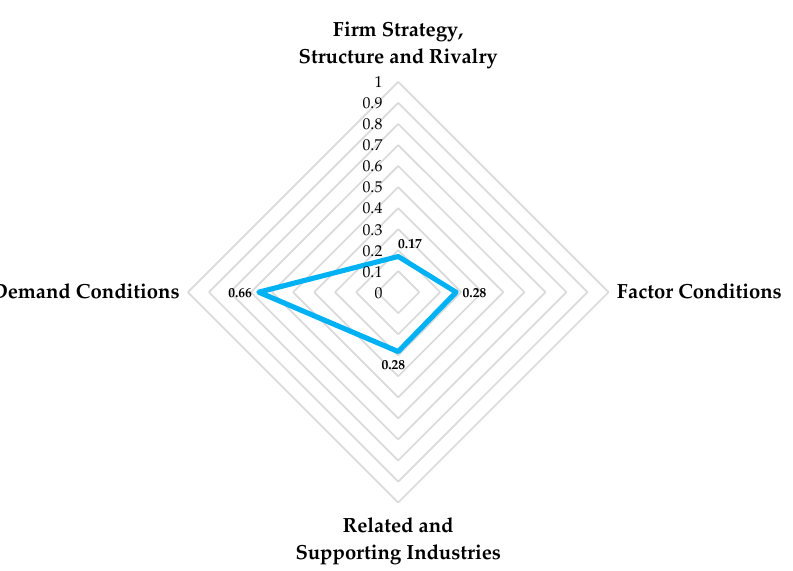
Figure 4. Porter’s diamond model applied at the level of Romanian counties—average per diamond attribute. Source: authors’ own calculations based on data from Table 8.